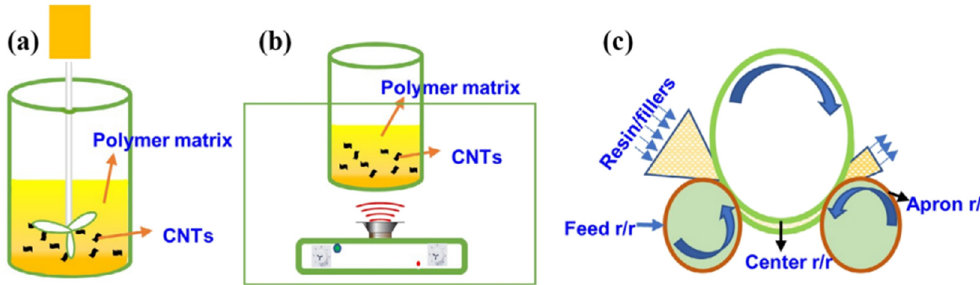
Figure 7: The schematic of CNTs dispersing into the polymer matrix. ( a ) Shear mixing, ( b ) ultrasonication, and ( c ) three - roll calendar mixing [ 36 ] .